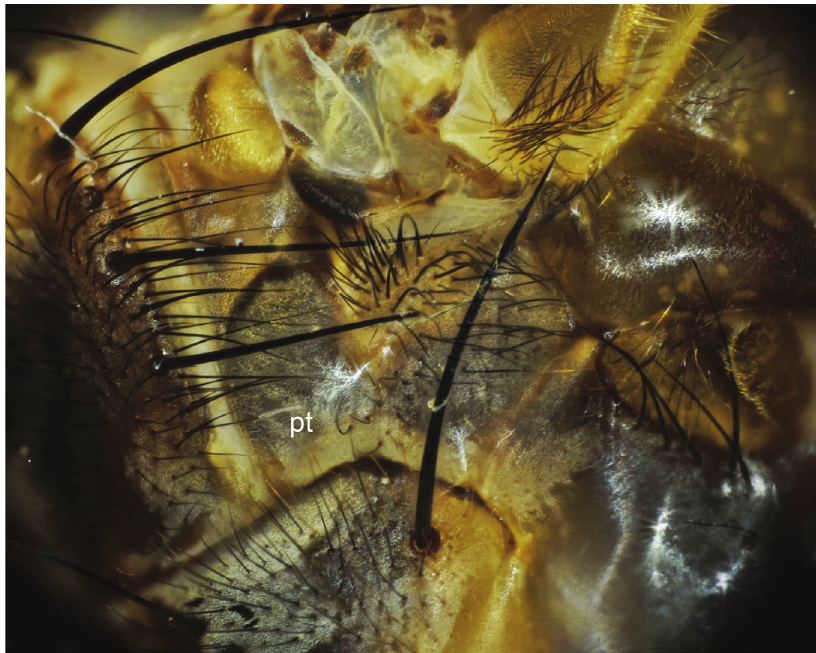
Figure 3. Pteropleuron (pt) of Bengalia escheri Bezzi, hairs on pteropleuron are largely